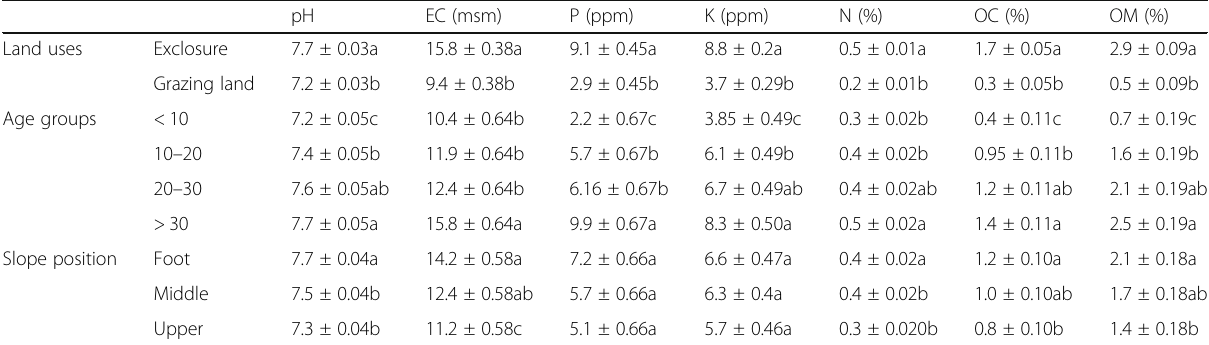
Table 9 Soil properties in exclosures and adjacent grazing lands with increasing age of exclosures and slope position